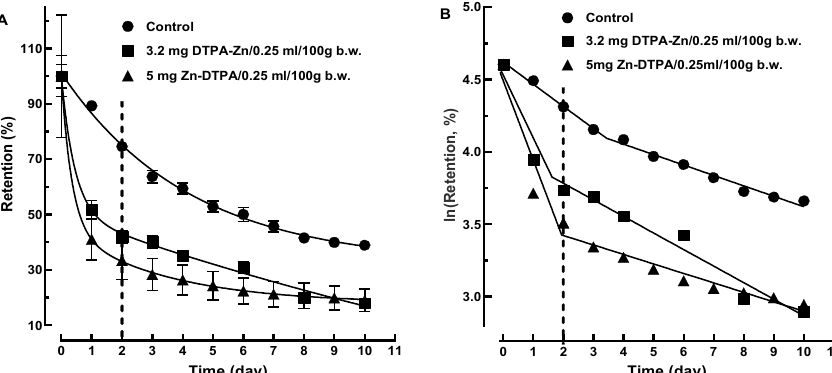
Figure 5. Biphasic kinetics modeling of 65 ZnCl 2 decorporation following rapid intervention with Zn-DTPA in rats. ( A ) Biphasic exponential time dependence of the 65 Zn % retention. ( B ) Linear time dependence of the logarithmic transformation of 65 Zn % retention. Data represent means ± SEM ( n = 7).